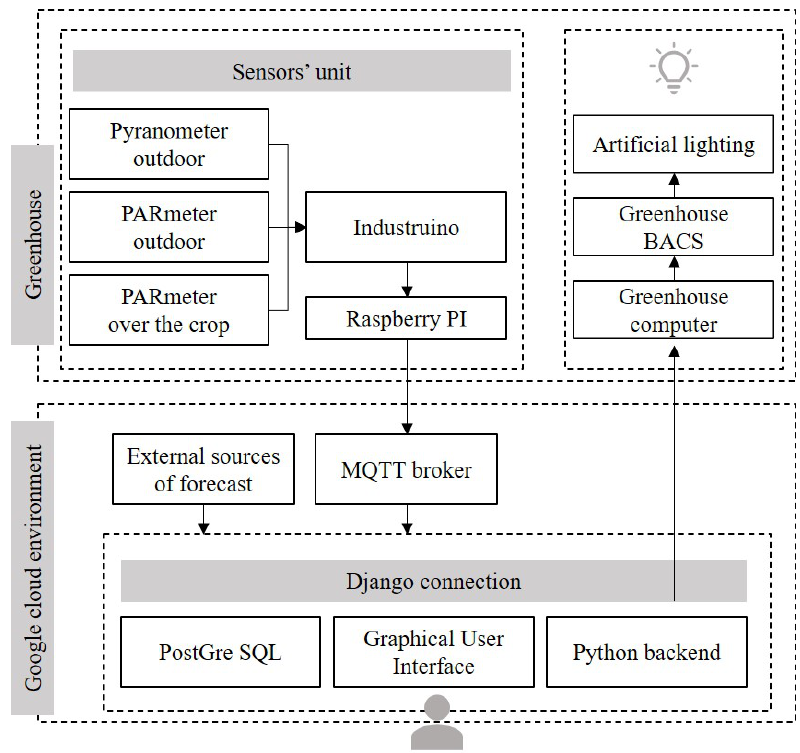
Figure 8. Schematic of the software layers and their respective integration in the